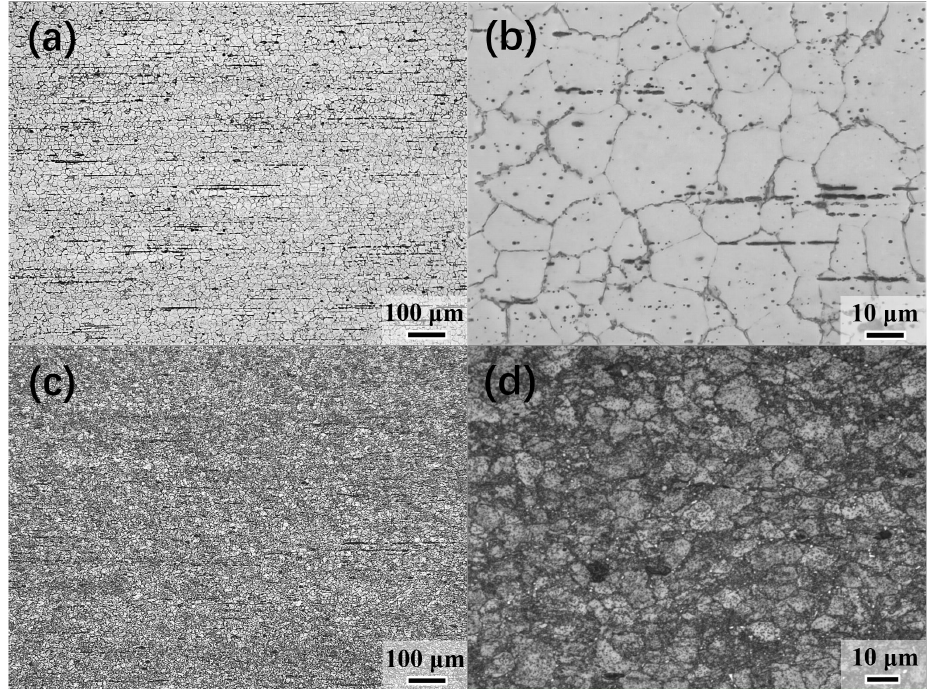
Figure 2. Optical microscope (OM) images of ( a , b ) as-extruded and ( c , d ) caliber-rolled AB83 alloy.